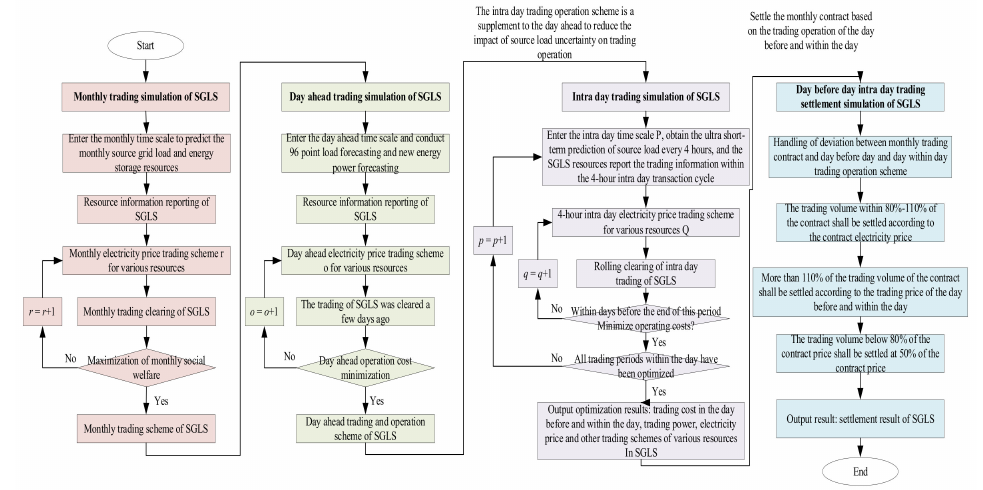
Figure 3. Multi-time scale trading simulation flow of SGLS based on continuous trading